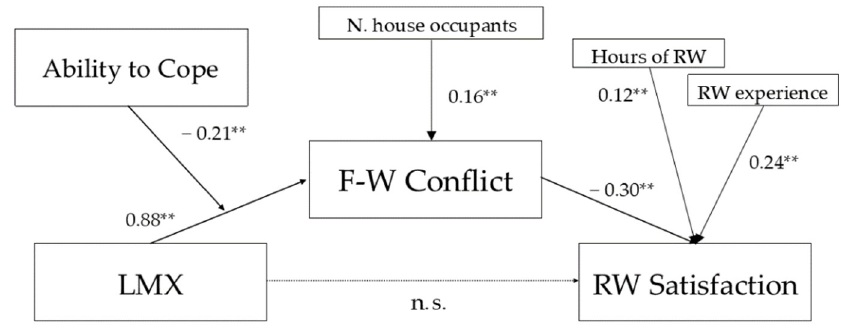
Figure 1. Tested model. ** p < 0.01; n.s. = not significant.